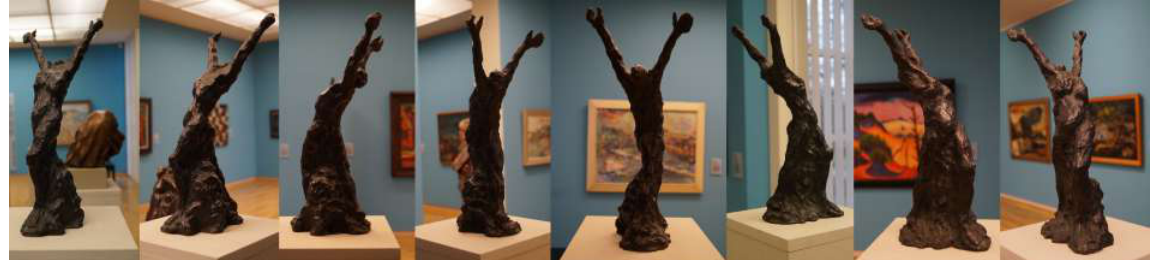
Figure 1. Eight reference images of different directions of the sculpture Moses by Kroner,